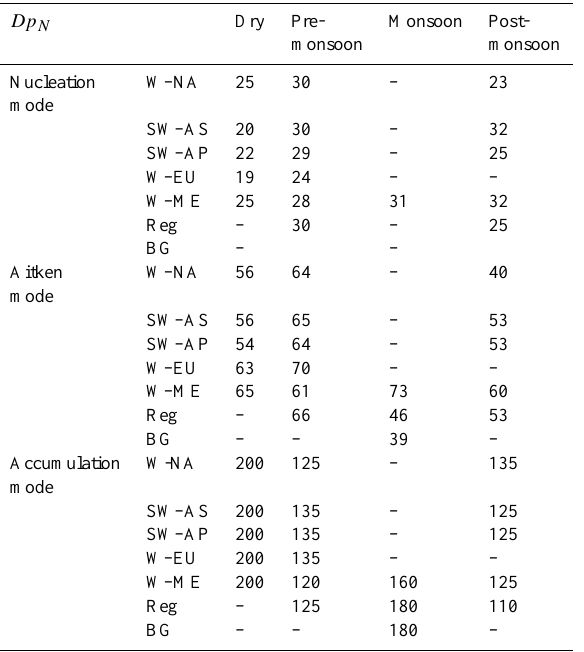
Table 4. Geometric Mean number diameter of the Nucleation, Aitken and accumulation modes during different seasons segregated into air mass